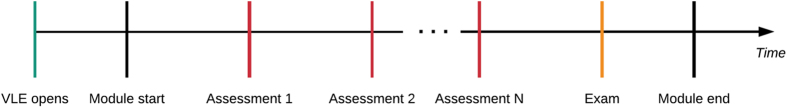
Typical module structure.Module-presentation content is usually available in VLE couple of weeks before official module start. During the presentation the students’ their knowledge is evaluated in series of assessments, which defines the milestones in the module. At the end, there is usually the final exam.